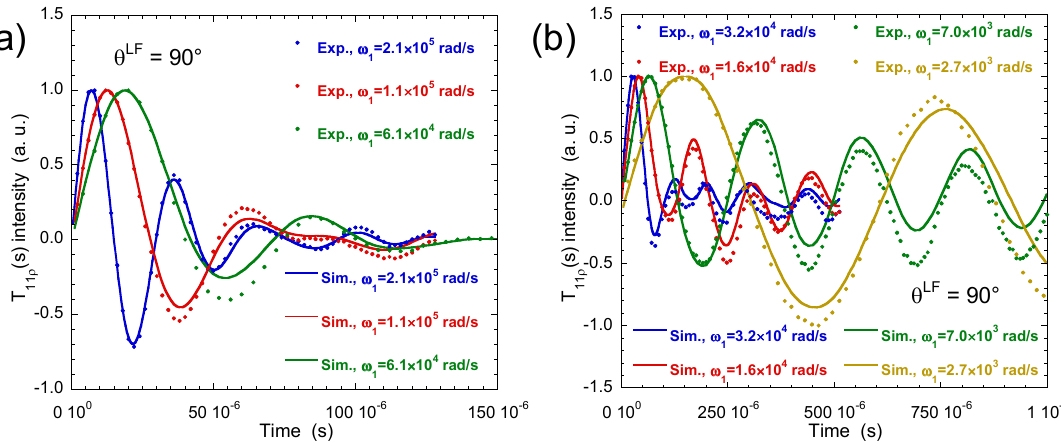
Figure 11. Time evolutions of the spin-locking relaxation measurements ( 133 Cs NMR) for seven irradiation powers corresponding to various angular velocities ω 1 : ( a ) decreasing from 2.1 × 10 5 to 6.1 × 10 4 rad · s − 1 ; and ( b ) decreasing from 3.2 × 10 4 to 2.7 × 10 3 rad · s − 1 (see the text). Reprinted with permission from [55]. Copyright (2015) American Chemical